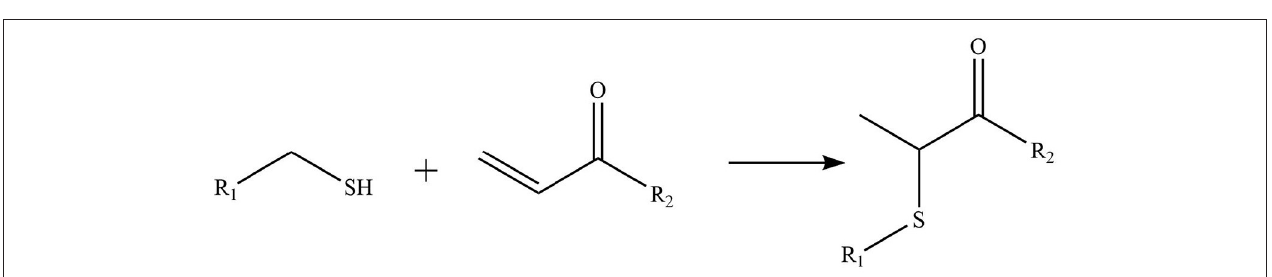
TLR4. Therefore, curcumin can inhibit LPS-induced activation of both MyD88- and TRIF-dependent pathways of TLR4, and results in the inhibition of both NF-kB and interferon regulatory factor 3 (IRF3)